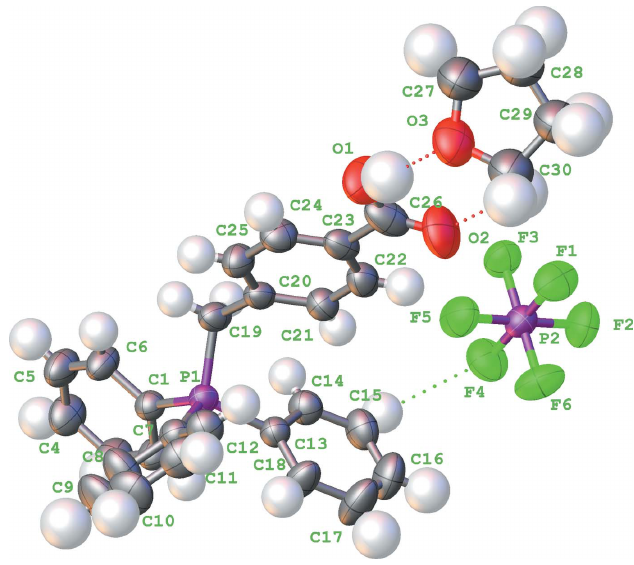
Figure 1 Structure of title compounds with 50% probability ellipsoids. The disordered portion of the solvent molecule is omitted for clarity.